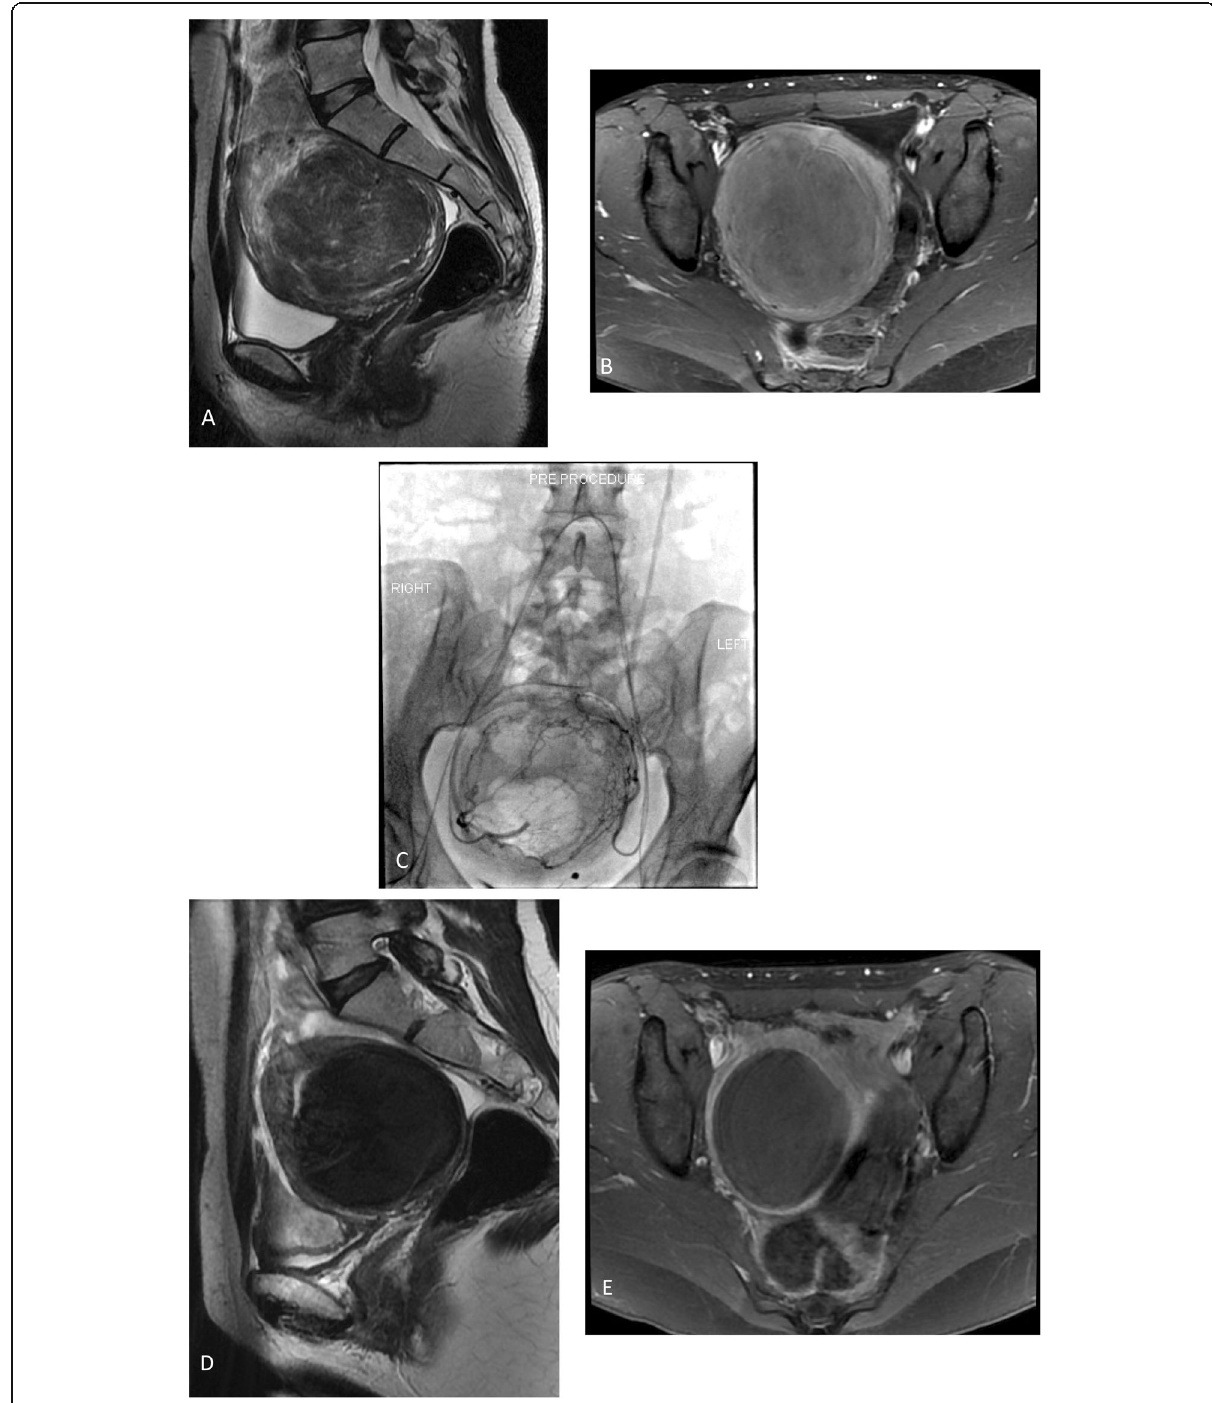
Fig. 1 Forty year-old-female patient. a Sagittal T2-weighted MR image shows a single large intramural fibroid. b A baseline MRI scan shows intense enhancement of the fibroid. c Uterine arteriograms before embolization: Fluoroscopic image obtained in the arterial phase shows bilateral hypertrophied uterine arteries with a large fibroid uterus due to uterine fibroids. d Sagittal T2-weighted MRI 6 months following uterine artery embolization demonstrates a reduction in the uterine and fibroid volume. e Post embolization T1-weighted MR image shows 100% infarction with decreased fibroid